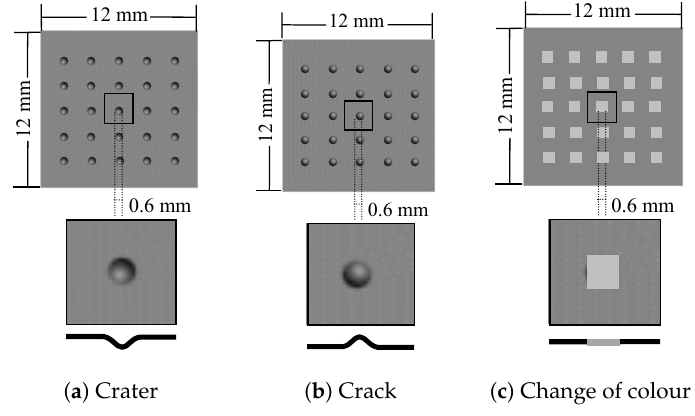
Figure 9. Defects considered in the